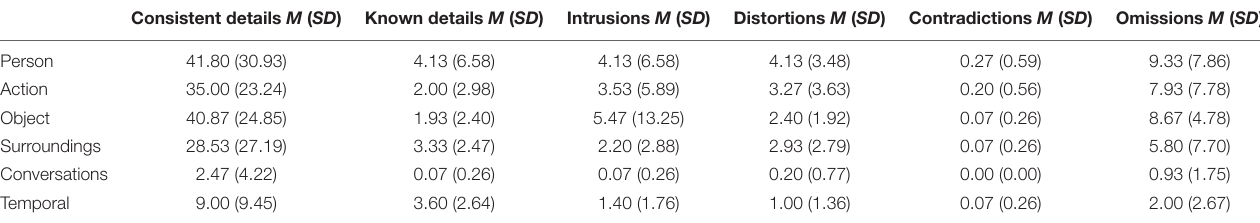
TABLE 3 | Means and standard deviations for consistency categories by detail type across interview-statements ( N =